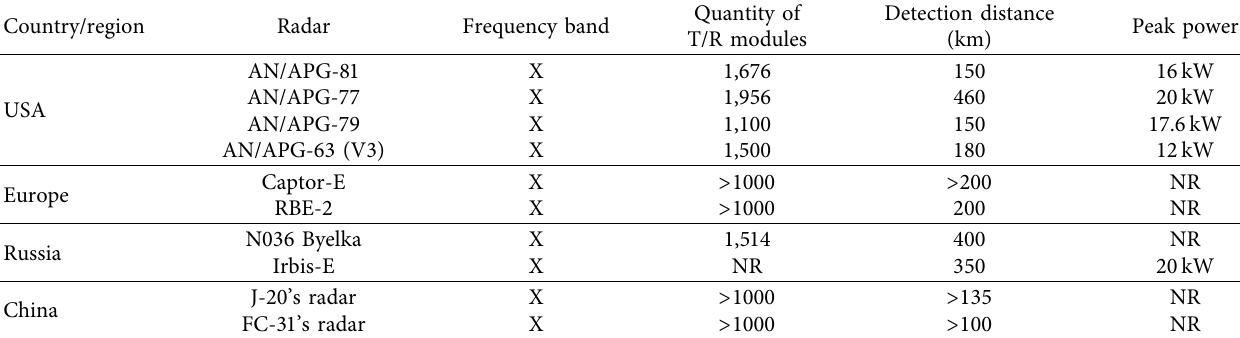
Table 3: Main parameters of diferent airborne radar.